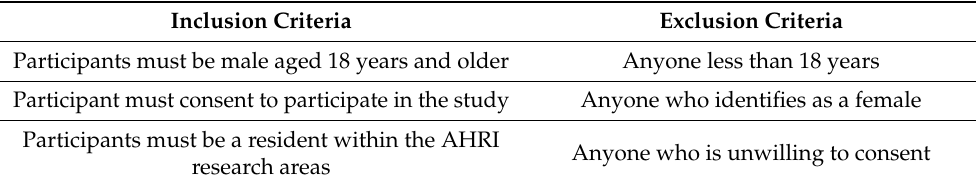
Table 1. Study inclusion and exclusion criteria. Inclusion